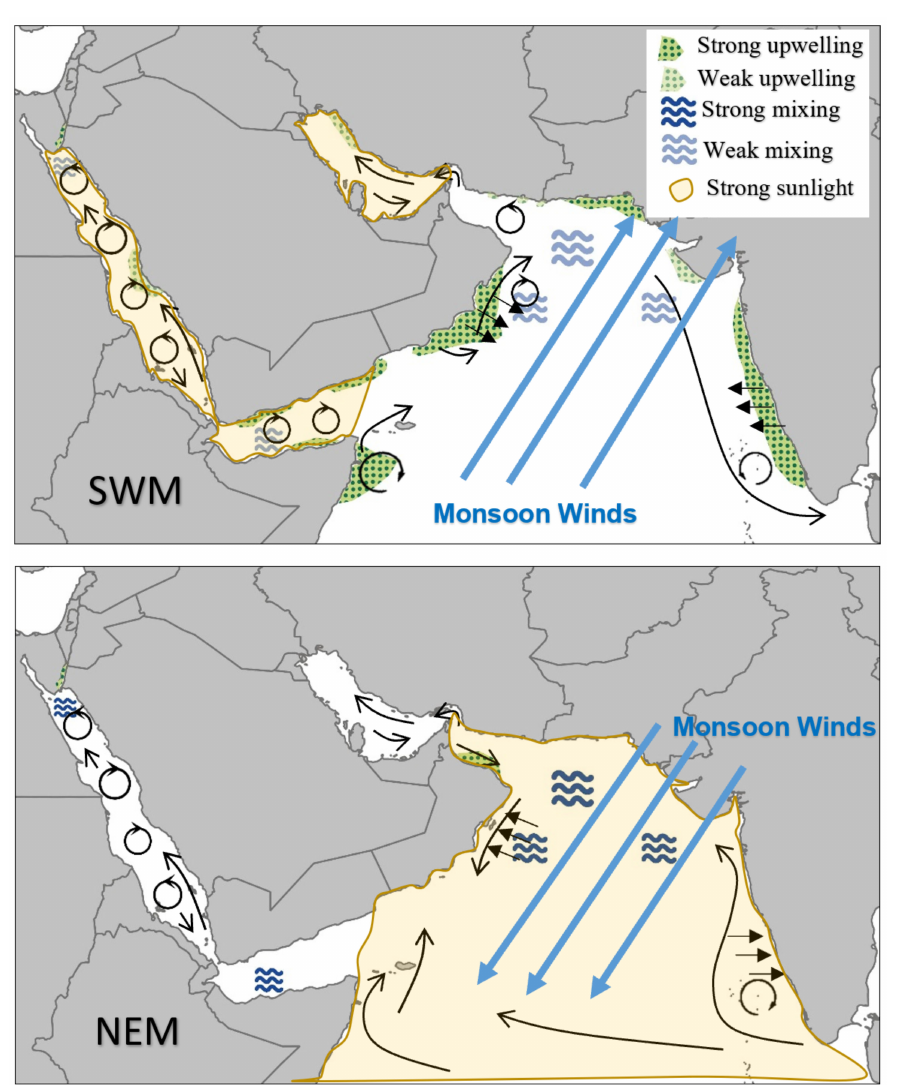
Figure 2. The major dominant physical oceanic features: upwelling, mixing, and advection that occur in the north Indian Ocean during NEMs and SWMs. Strong upwelling is indicated by the darker green color, while the weak upwelling is indicated by the light green colors. Mixing is represented by the blue wavy lines; the dark blue lines represent strong mixing, and the light blue lines represent weak mixing. Advection is shown by the black arrows, which illustrate the direction of the horizontal flow. The high sunlight radiation coverage is also represented during NEMs and SWMs. Monsoonal winds are shown with the blue arrows: northeasterly during SWMs and southwesterly during